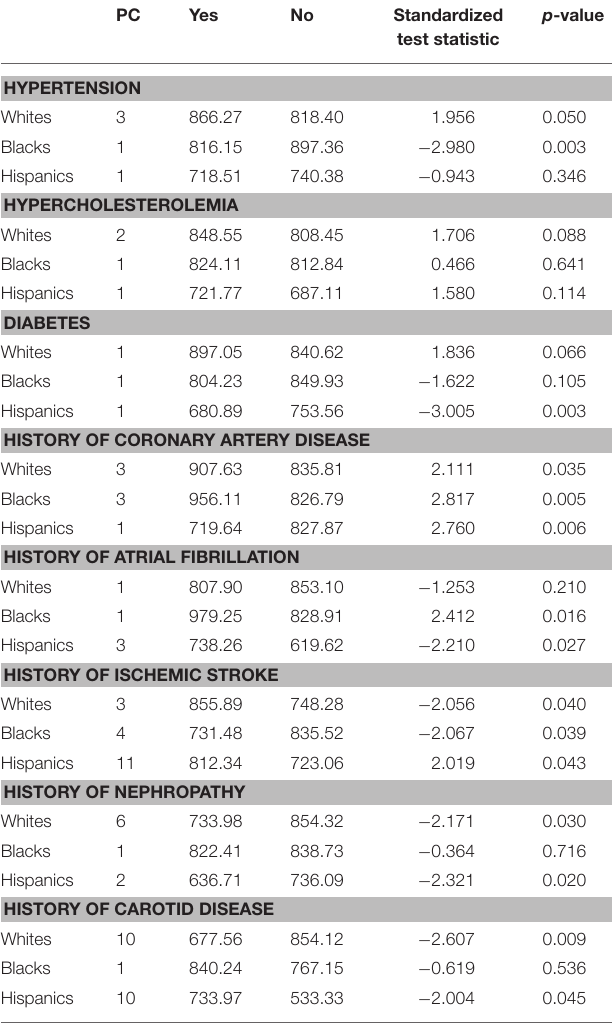
TABLE 2 | Distribution of vascular risk factors across genetic ancestry (Principal Component 1) among affected and non-affected individuals. Yes No p -value